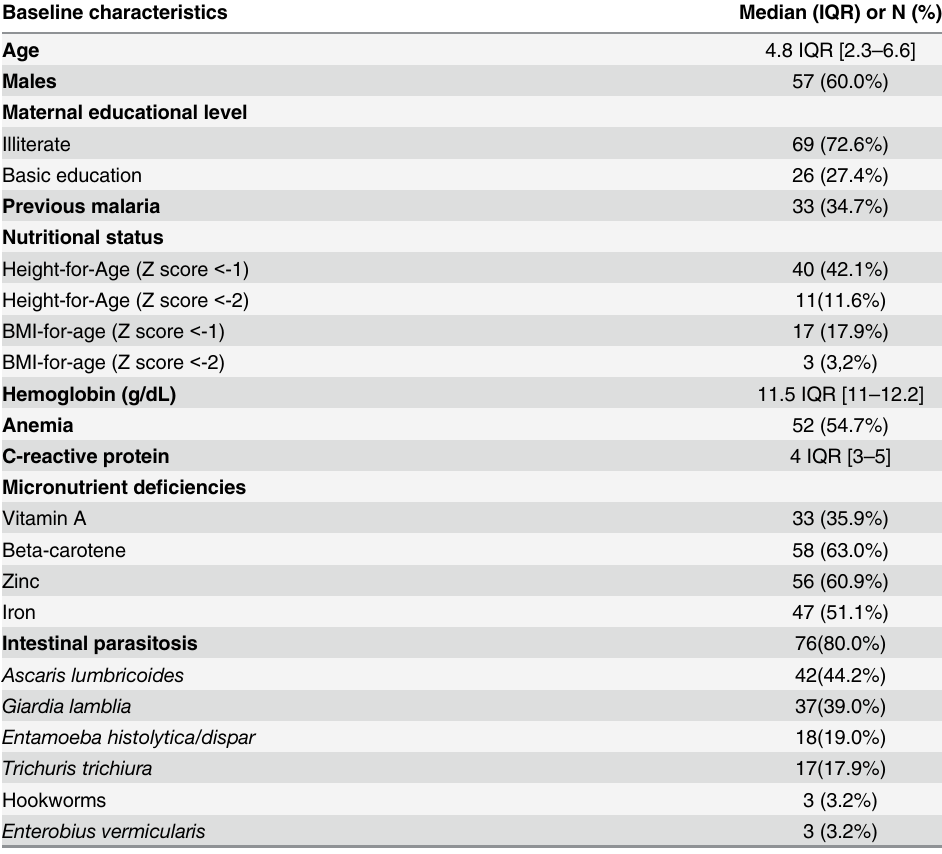
Table 1. Baseline characteristics of 95 children evaluated for nutritional and micronutrient status in Careiro, Brazil, May